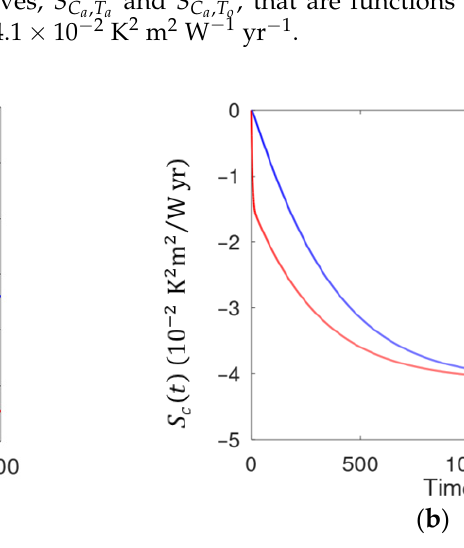
Figure 6. Sensitivities of global mean surface temperature (red line) and global mean deep ocean temperature (blue line) with respect to parameter C a , calculated for linear forcing: ( a ) over time interval 0–200 years, ( b ) over time interval 0–2000 years.